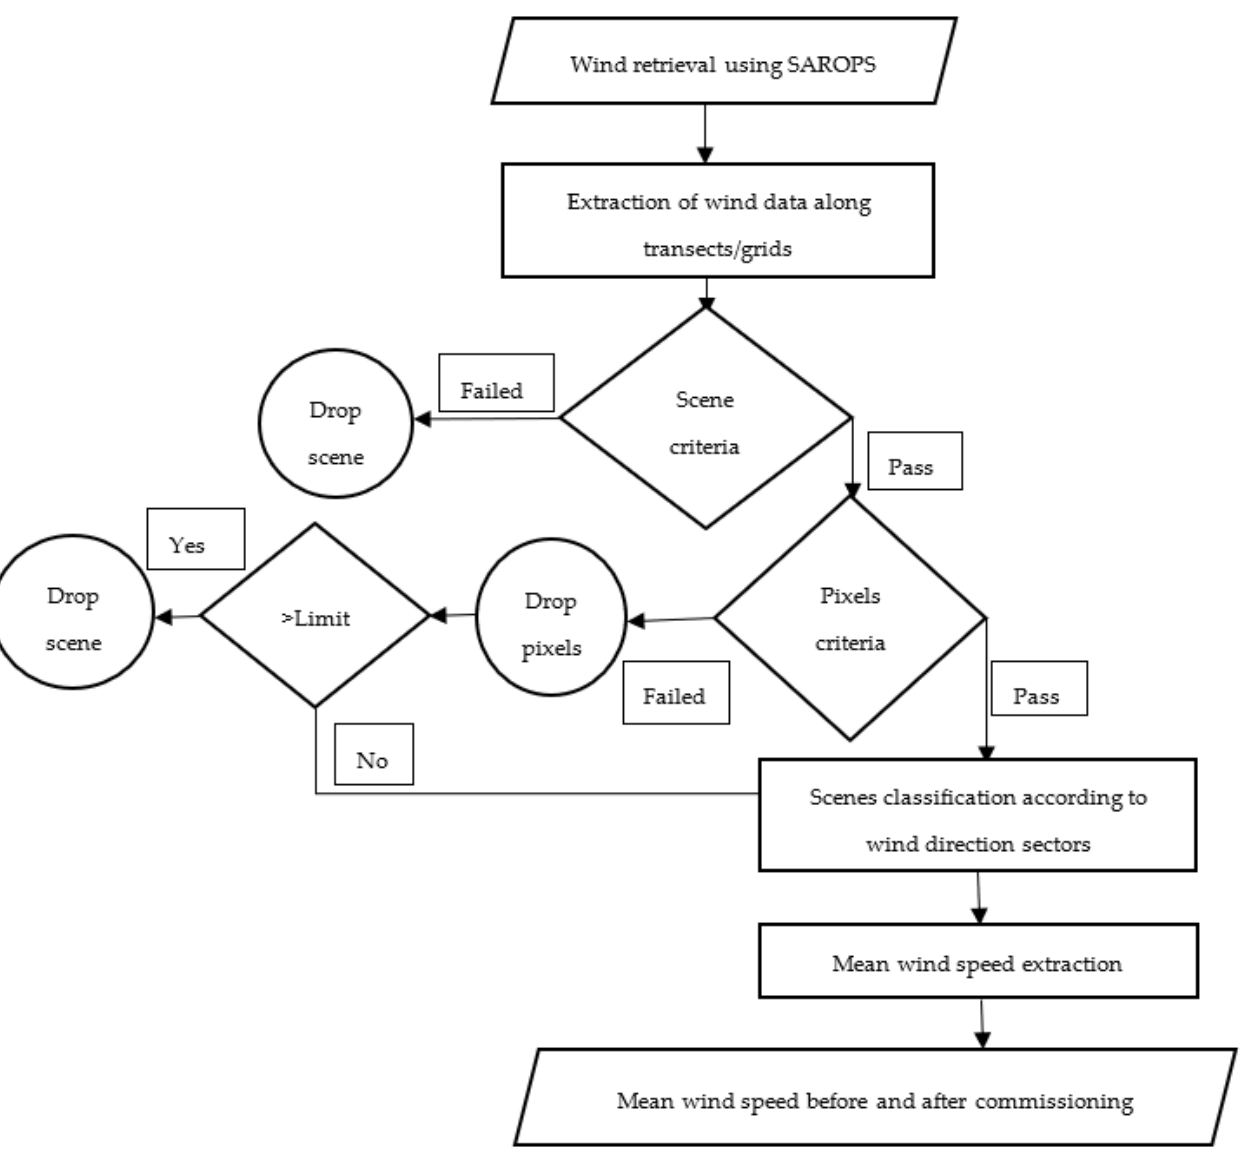
Figure 2. Flowchart illustrating the processing steps and criteria set for the analysis of the mean wind speed from the selected SAR scenes for both investigated periods (before and after commissioning) for each site.